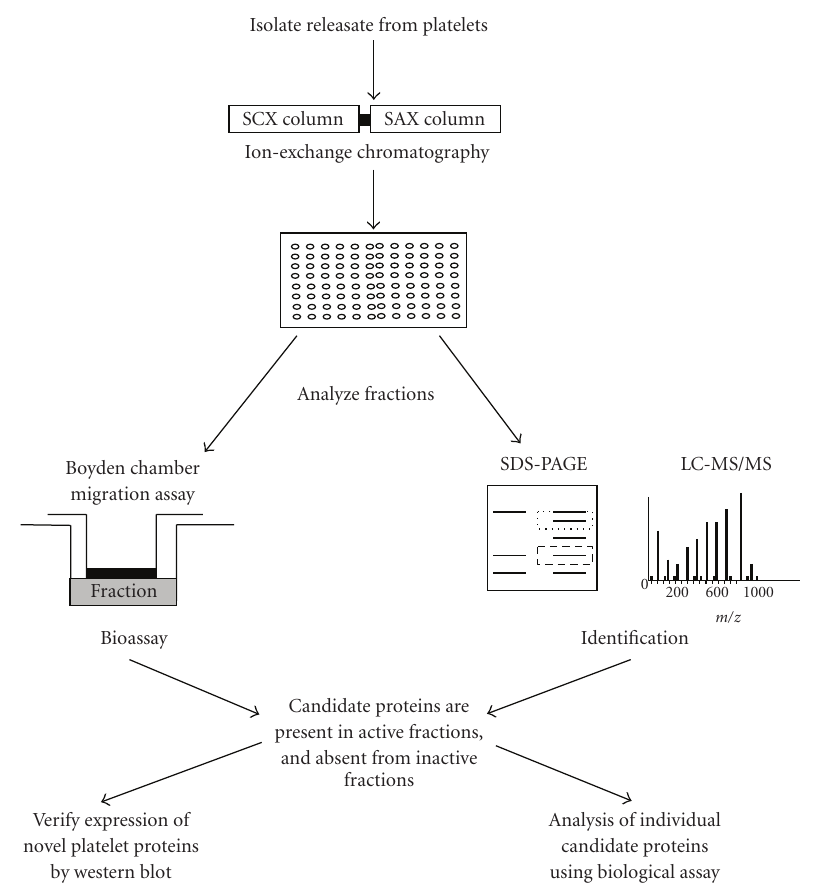
Figure 1: Strategy for linking function and protein identity in biofluids. An o ff -line MuDPIT strategy was used to identify biologically active proteins from a complex mixture. Proteins released from platelets were separated by SCX/SAX chromatography. The collected fractions were analyzed for pro-migratory activity using a monocyte Boyden chamber assay. The fractions were separated in the second dimension by SDS- PAGE, and gel lanes were excised and the proteins were digested with trypsin. The resulting peptides were separated by RP-HPLC, ionized by electrospray, and subjected to MS/MS to identify potential pro-migratory